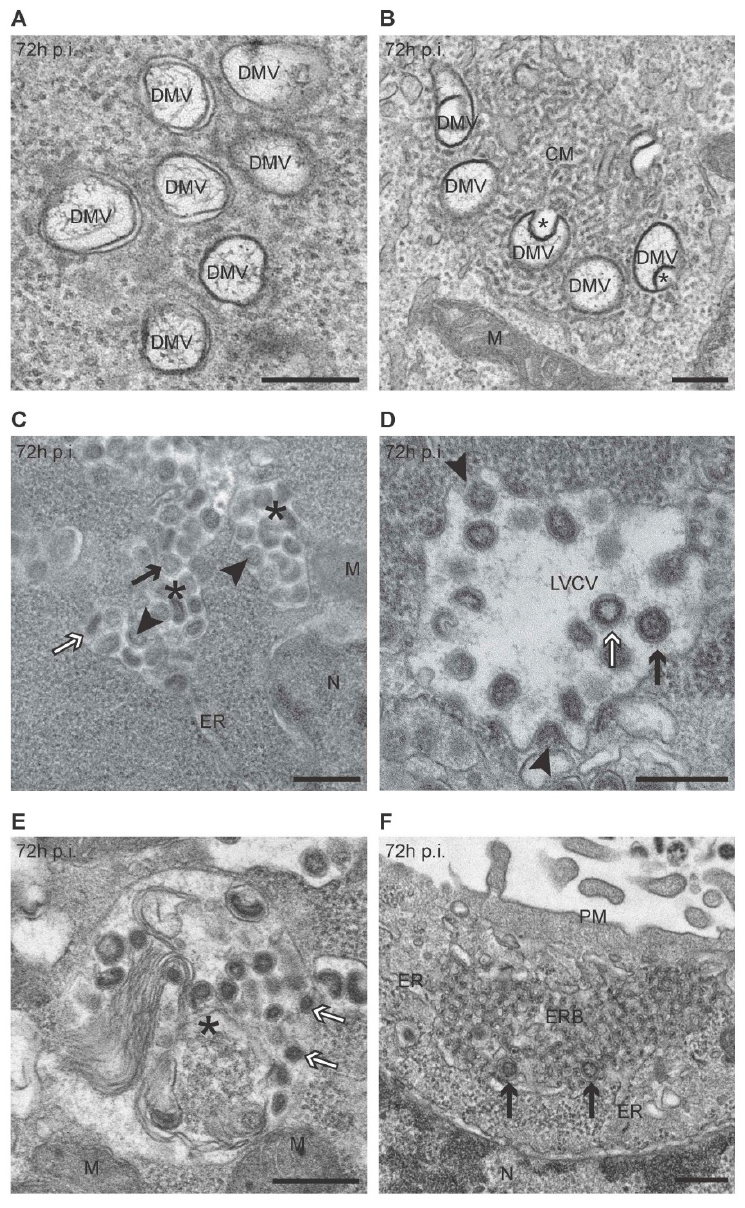
Figure 1. Porcine epidemic diarrhea virus (PEDV) induces the formation of multiple membranous structures. Vero E6 cells were inoculated with PEDV (multiplicity of infection (MOI) = 1) and processed for electron microscopy (EM) at 72 h p.i. as described in the Materials and Methods section. ( A , B ) Representative electrographs of double-membrane vesicles (DMVs) and convoluted membranes (CMs) are shown. Asterisks indicate invaginations of the DMVs limiting membrane; ( C ) expanded ER with luminal virions (asterisks). Arrowheads indicate forming viral particles. Black and white arrows indicate immature and mature virions, respectively; ( D ) large virion-containing vacuoles (LVCVs) are large organelles with a smooth single limiting membrane and virions at their interior. Virions can be seen as invaginations of the limiting membrane (arrowheads). Black and white arrows indicate immature and mature virions, respectively; ( E ) large single-membrane compartments containing mature virion particles (asterisk), and filled with condensed membrane whorls and amorphous material/structures. White arrows indicate mature virions; ( F ) cytoplasmic inclusions composed of condensed tubular structures containing a dense inner core were observed connected to the endoplasmic reticulum (ER), which we named ER bodies (ERBs). From time to time, virus particles were observed in their interior (arrows). ER: endoplasmic reticulum; M: mitochondrion; N: nucleus; PM: plasma membrane. Scale bar: 250 nm.